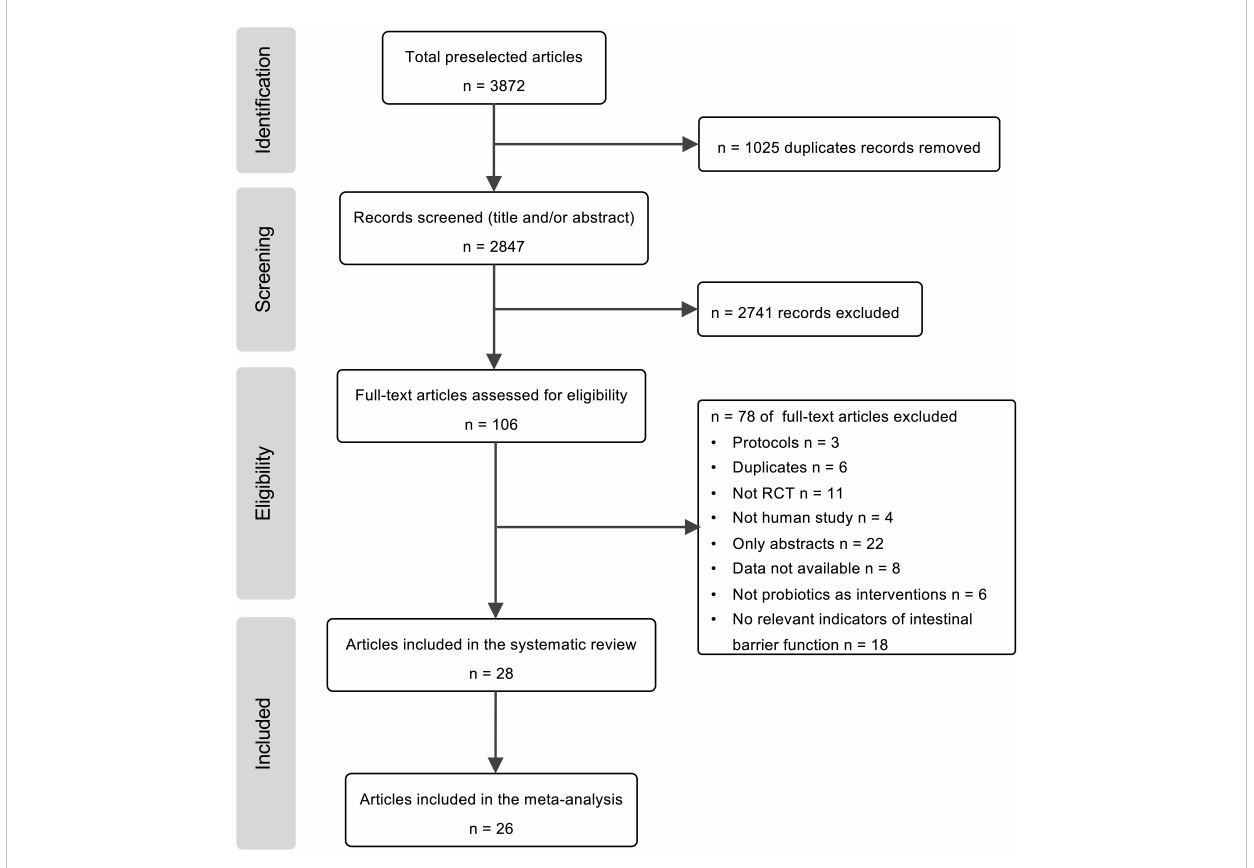
FIGURE 1 Flow diagram of study selection progress for the systematic review and